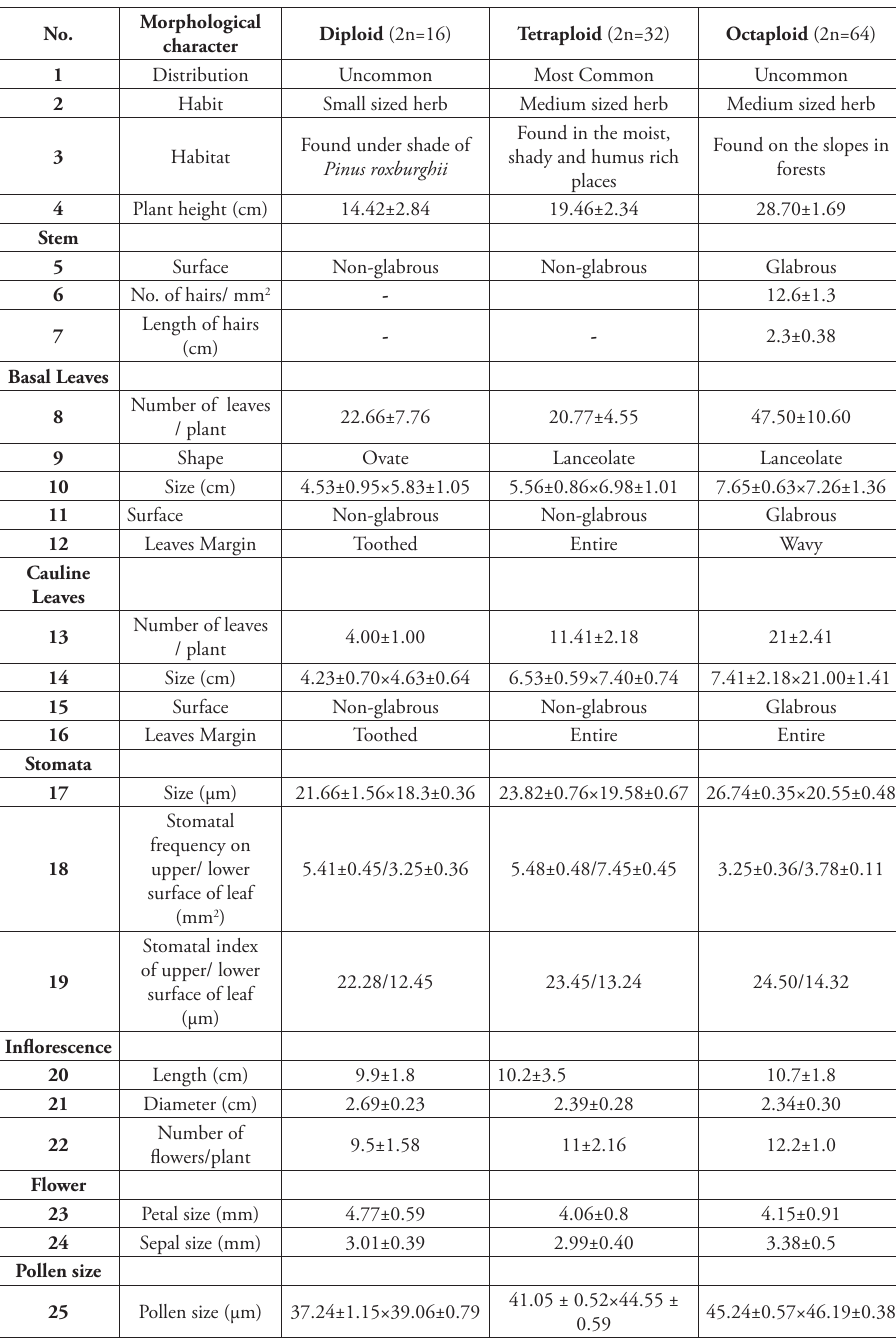
Table 2. Detailed morphological comparison of three cytotypes of Valeriana jatamansi